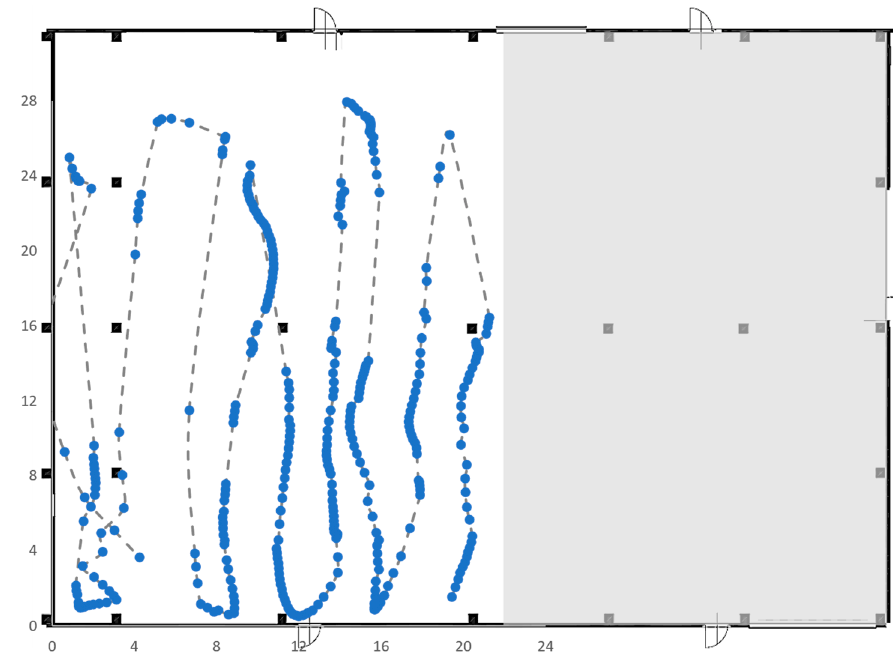
Figure 19. Trajectory followed by the tag in Test 2.